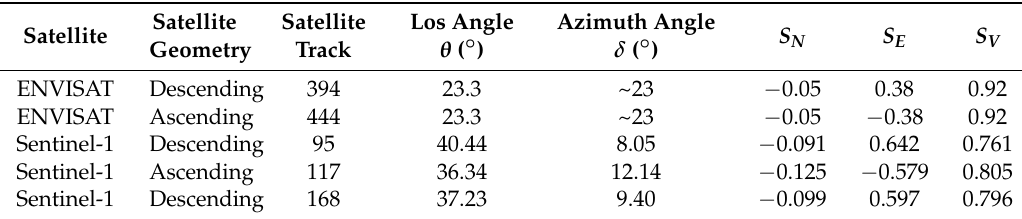
Table 3. Parameters of the Sentinel and ENVISAT images used for this work.